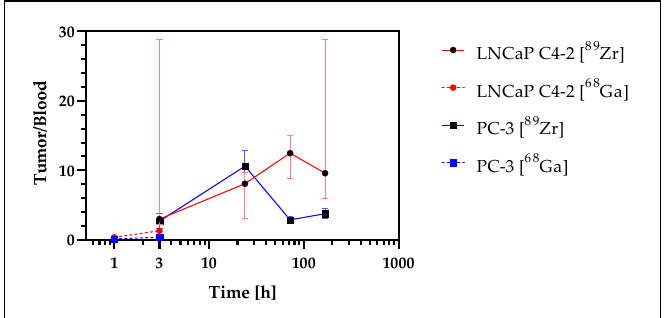
Figure 10. Combined graphs of tumor-to-blood ratios (median and interquartile range) of the [ 68 Ga]Ga-DFO-ND (1 h, 3 h) and [ 89 Zr]Zr-DFO-ND (3 h, 24 h, 72 h, 168 h). The time axis was scaled in logarithmic order.